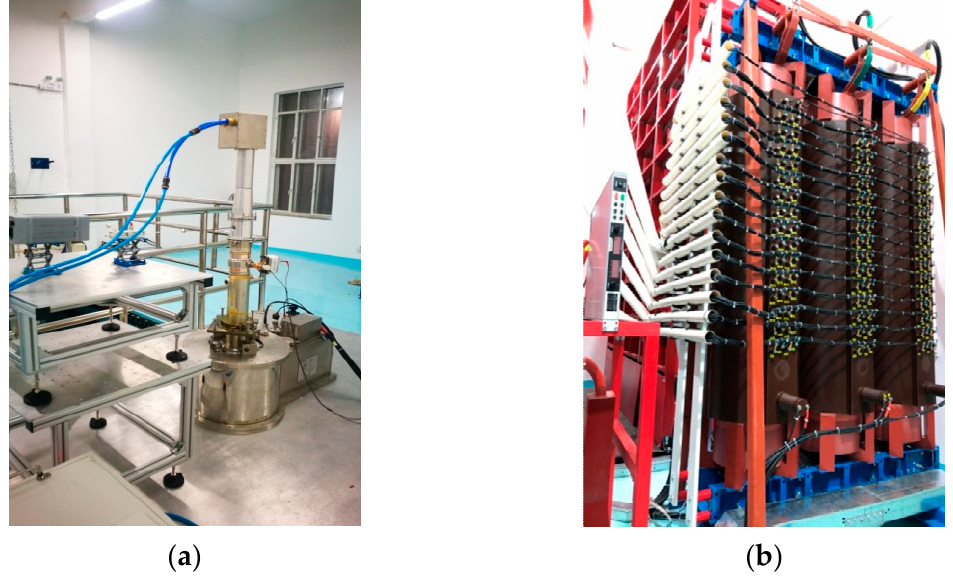
Figure 14. The 170 GHz gyrotron measurement system consisting of a superconducting magnet ( a ) and a high-voltage power supply ( b ).